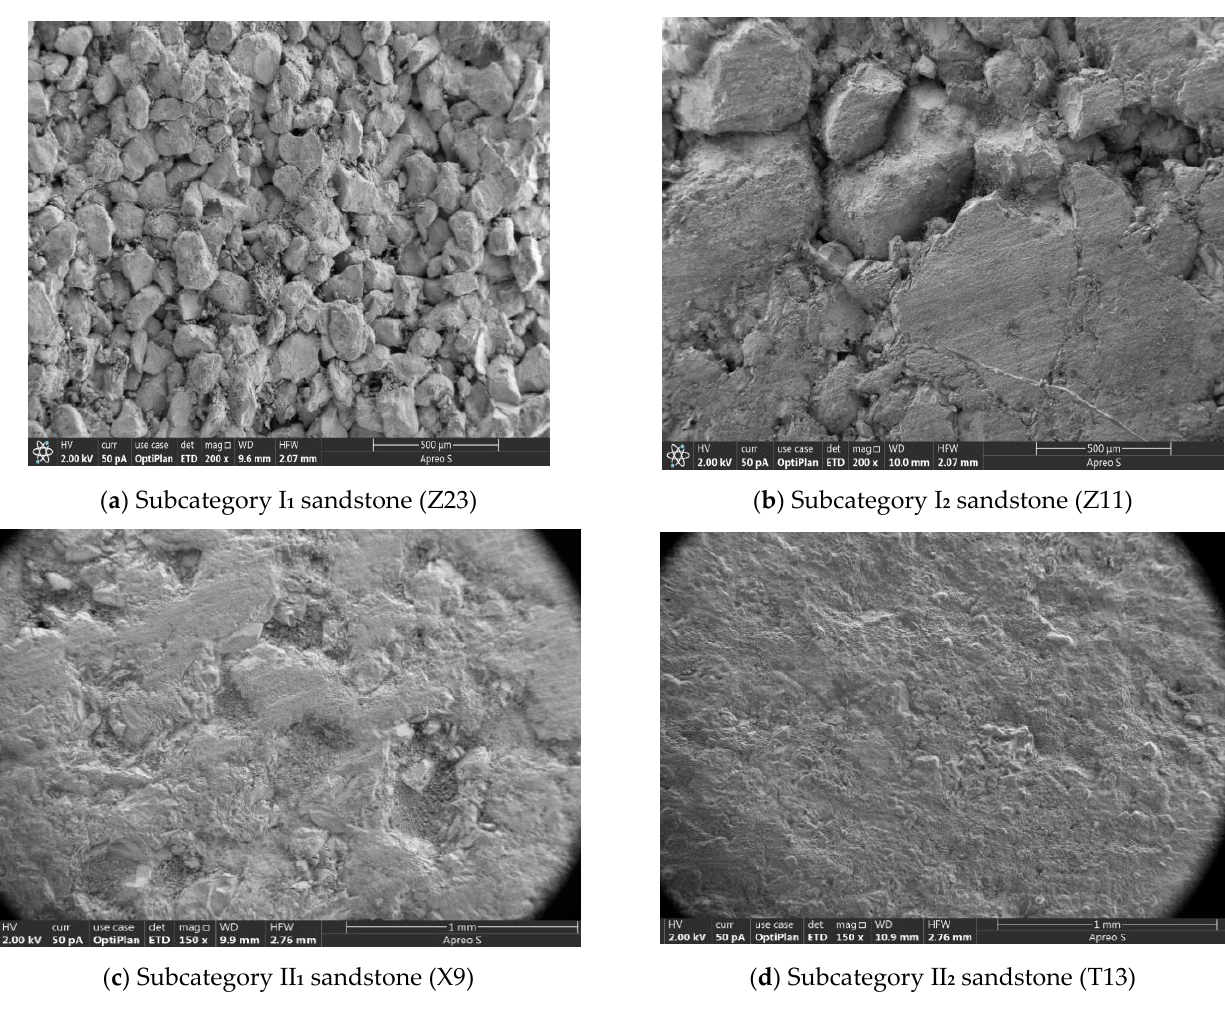
Figure 4. Comparison of pores, throats and connectivities among the four subcategories of sandstone under SEM. (Note that the images ( a – d ) in Figure 4 correspond to the images ( a – c ) and ( d ) in Figure 3, respectively).